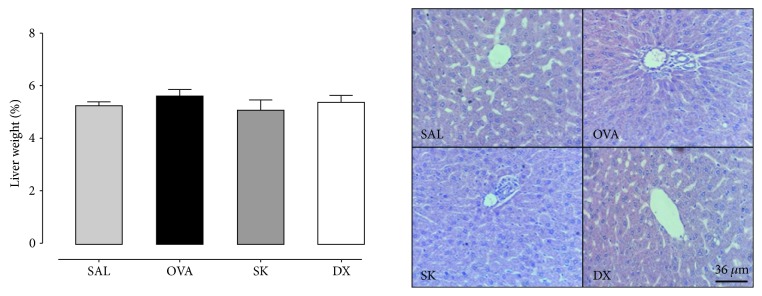
Sakuranetin did not induce liver morphological alterations in vivo. Liver percentage per animal weight and the histopathological slices of liver tissues. The liver morphological examinations were performed with H&E staining at a magnification of ×400; no morphological differences were observed among the groups. Data represent mean ± SEM from 7 to 8 mice per group.